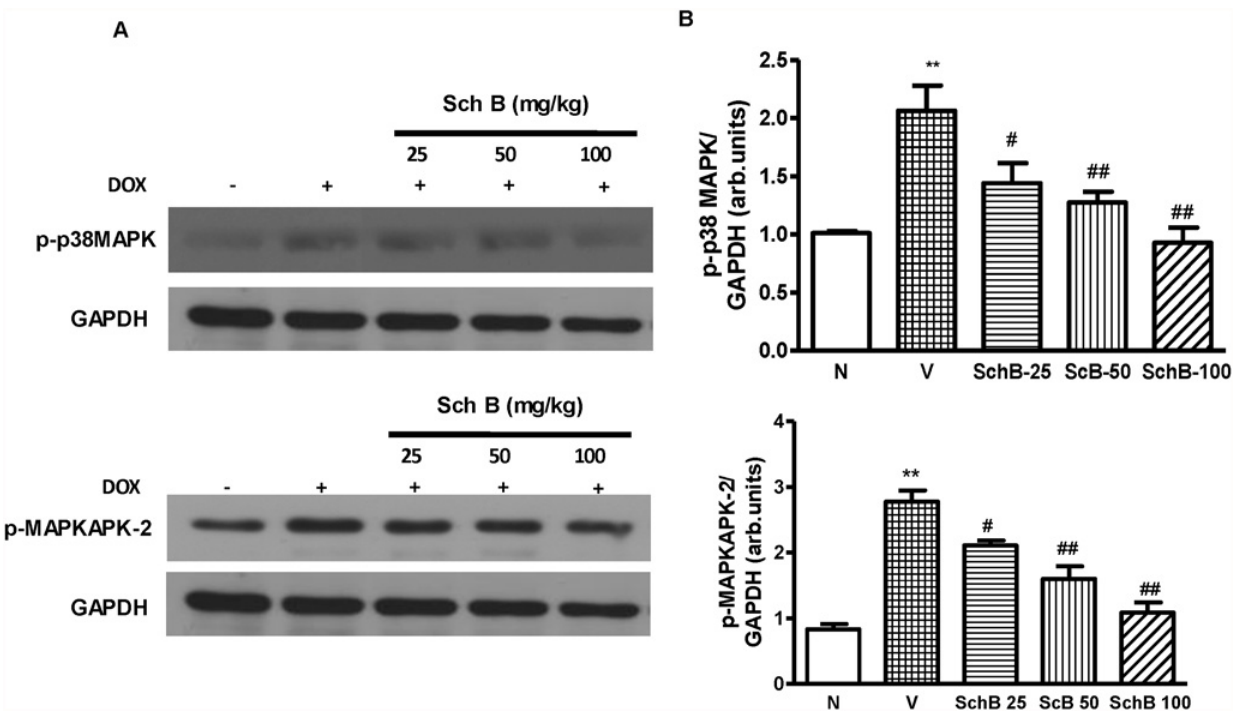
Fig 5. Reduced p38 MAPK activity in Sch B treated mice at 5 days after Dox injection. (A – D) Representative Western immunoblots and densitometry analysis using Scion image software for p-p38 MAPK (A and B) and p-MAPKAPK-2 (C and D). Blots were normalized against GAPDH. Each bar represents means ± S.E. (n = 3 – 5). ** P < 0.01 vs. group N mice; # P < 0.05 and ## P < 0.01 vs. group V